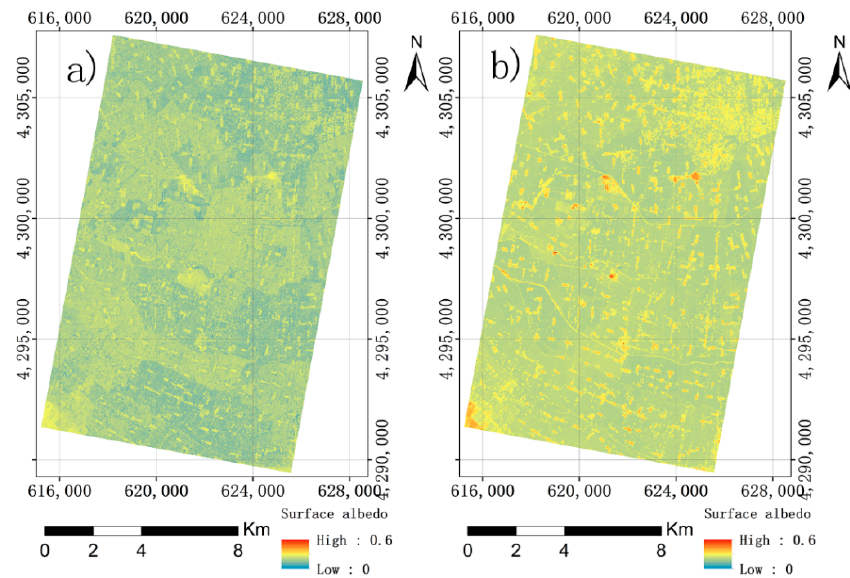
Figure 6. Surface albedo of the study area for ( a ) the June 4 th image and ( b ) the July 10 th image of 2008.